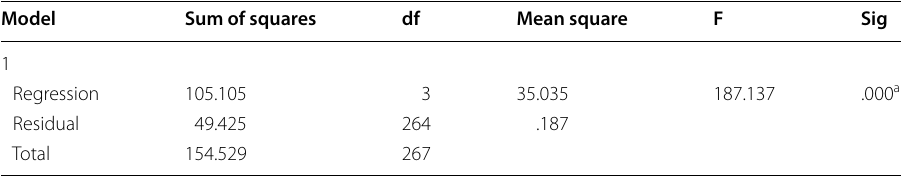
Model Sum of squares